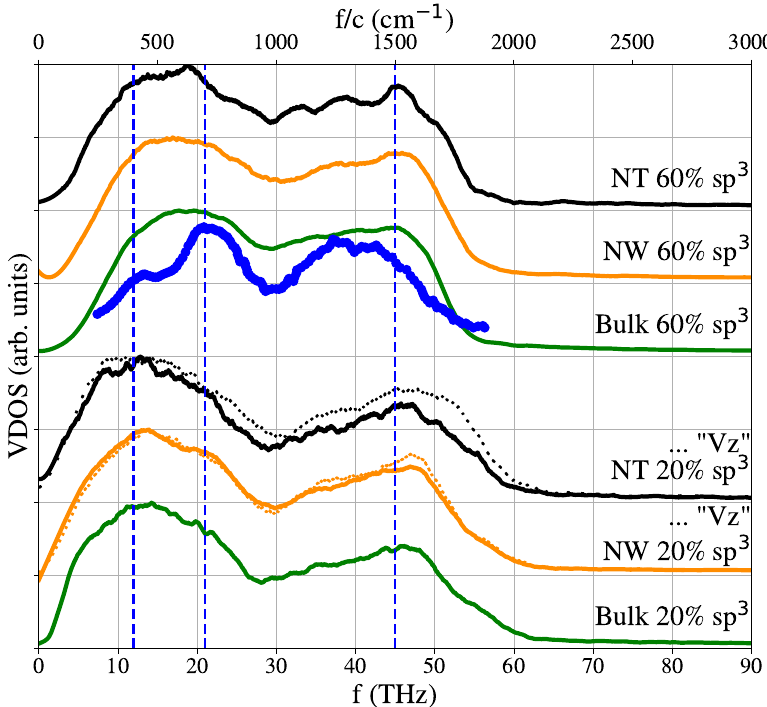
Figure 13. Vibrational density of states for bulk, NW and NT. 20% sp 3 shows no significant preferences in any particular direction, as shown by considering only z velocities, along the NW/NT axis. For 60% sp 3 hybridization, there are no significant changes that could explain the increase in their thermal conductivity. Dashed vertical blue lines representing 400 cm − 1 , 700 cm − 1 and 45.2 THz were placed to help guide the eye. The blue solid line represents the experimental values obtained by Lopinski et al.